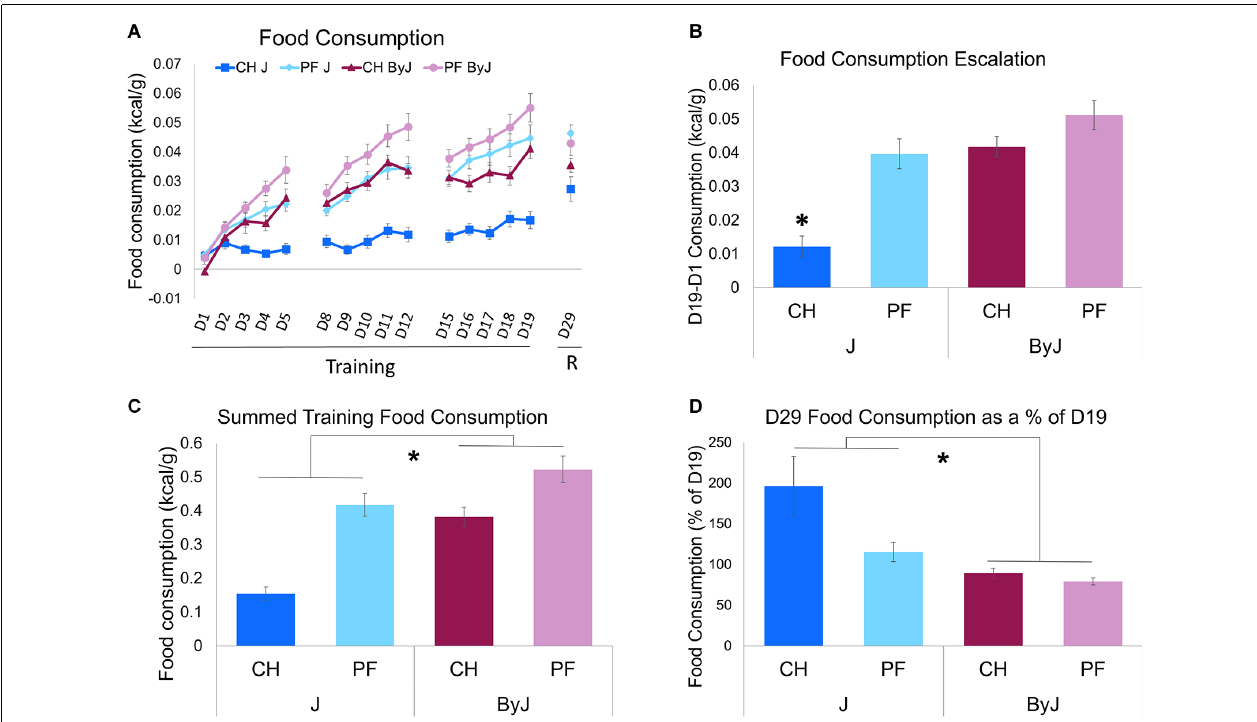
FIGURE 2 | Acute and escalated Palatable Food (PF) intake vs. Chow (CH) intake in BALB/cJ and BALB/cByJ substrains. (A) Food consumption across training days and during the re-exposure trial “R”. (B) Escalation of food consumption over training, normalized to body weight (D19-D1; * interaction between Diet and Substrain ( F (1,55) = 6.14, ∗ p = 0.016). (C) Summation of the total food consumed during training trials; * main effect of Substrain ( F (1,55) = 30.80, * p = 8.5e-7). (D) Change in food consumption from training to re-exposure. As a measure of re-exposure, the change in consumption (g/kcal) was examined from the final day of training (D19) to re-exposure (D29; * main effect of Substrain ( F (1,55) = 12.69, * p = 0.00077). Ns = 16 J female (8 PF, 8 CH), 15 J male (7 PF, 8 CH), 16 ByJ female (8 PF, 8 CH), 16 ByJ Male (8 PF, 8